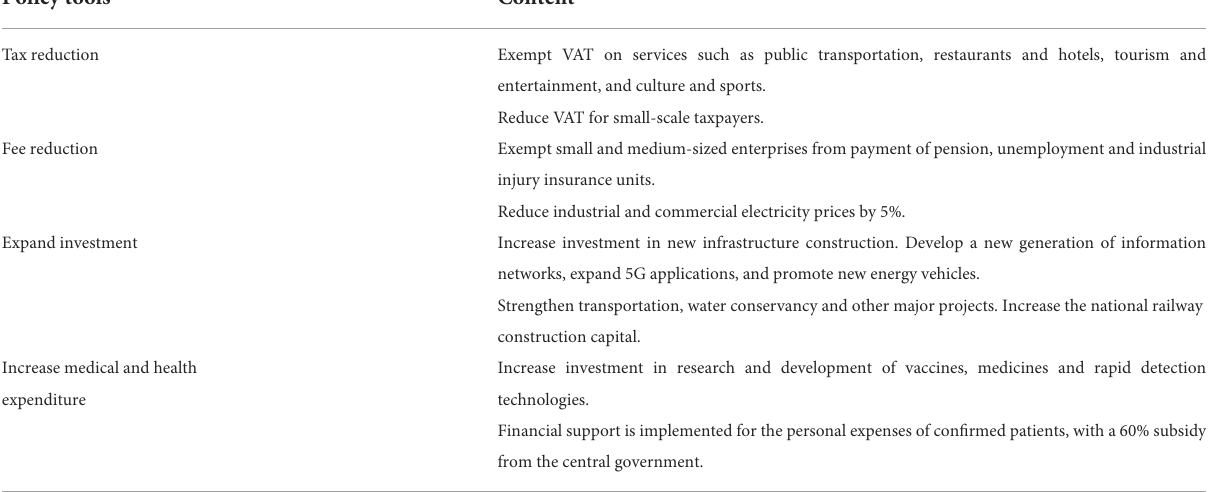
TABLE 1 Overviews of fiscal policies during the COVID-19 pandemic.